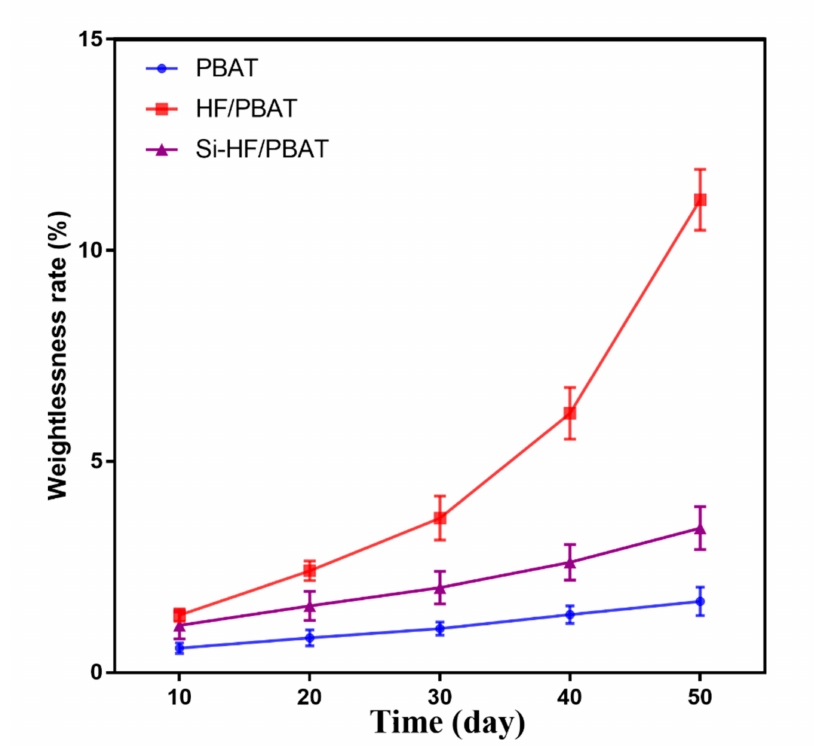
Figure 6. Effect of different treatment methods of hemp fiber on the biodegradability of composite